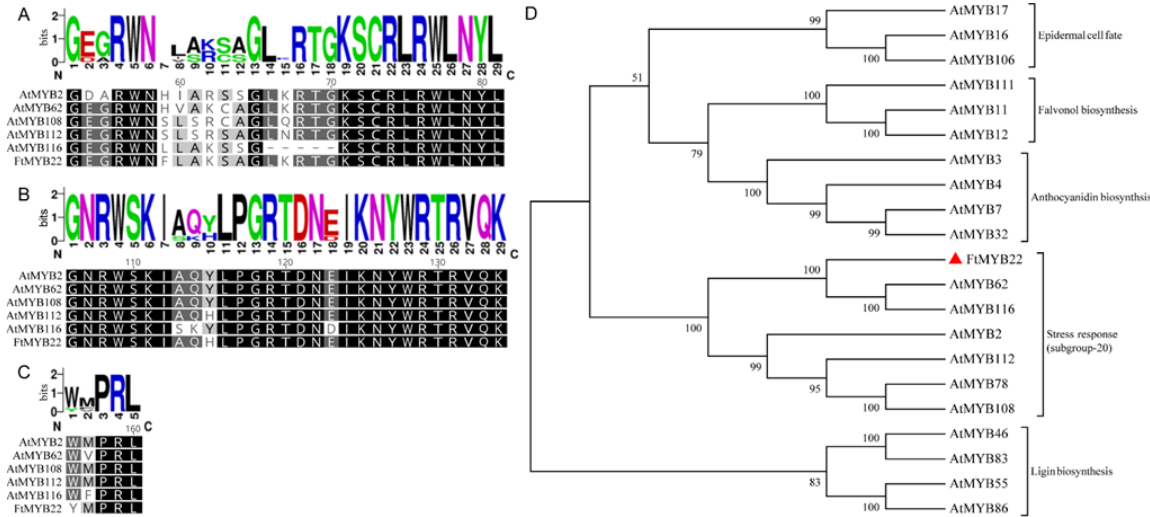
Figure 1. Multiple sequence alignments for conserved domains and the phylogenetic tree of FtMYB22. ( A ) R2-conserved domain. ( B ) R3-conserved domain. ( C ) WxPRL, SG20 subfamily- conserved domain. ( D ) The phylogenetic tree generated from the alignment of LFtMYB22 and